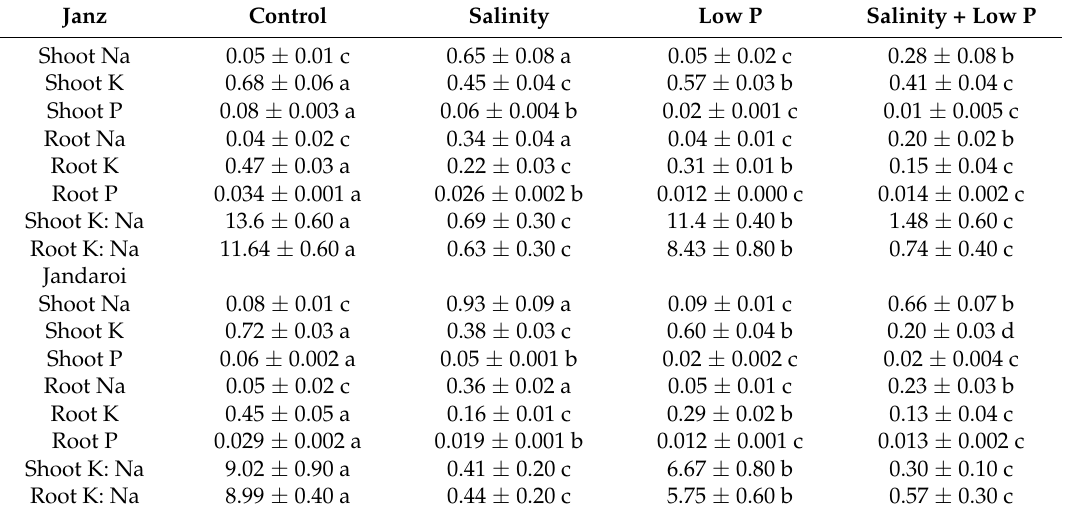
Table 2. Effects of salinity and low P supply, and their interactions on shoot and root ionic concentrations (mmol g − 1 DW) and K:Na ratios of salt-tolerant (Janz) and salt-sensitive (Jandaroi) wheat